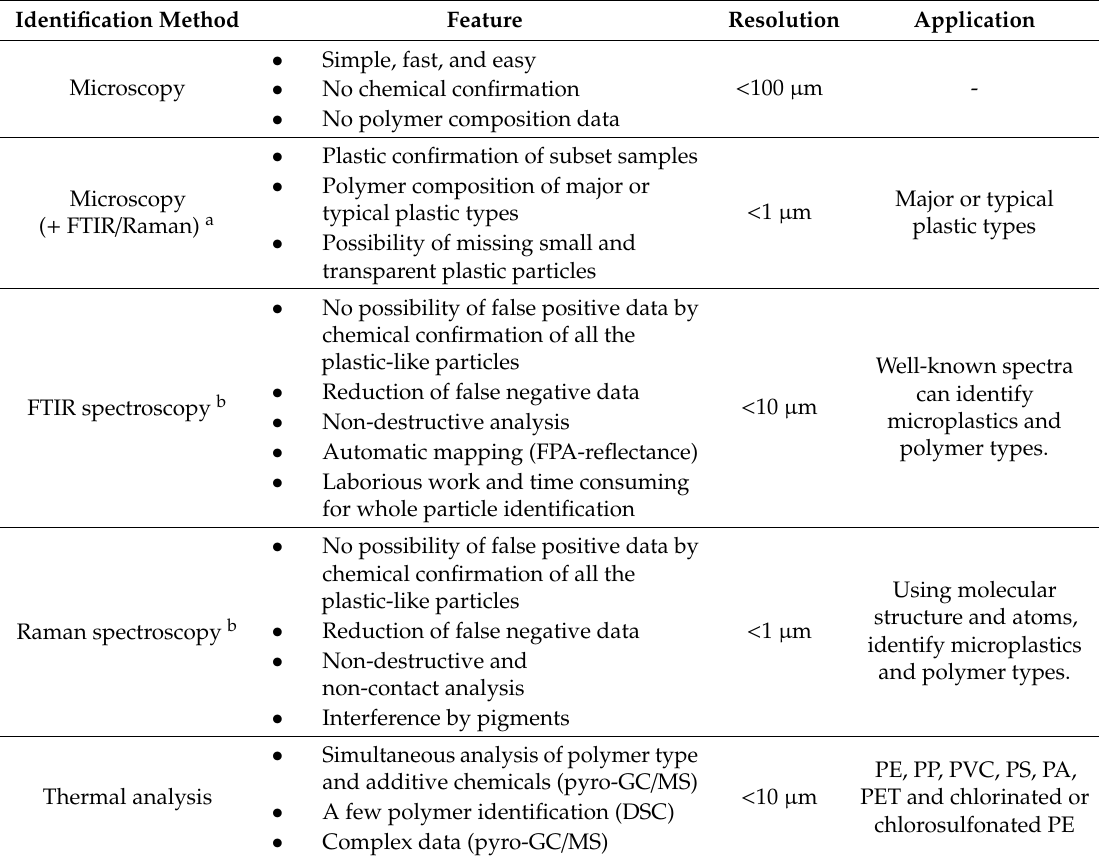
Table 2. Features, resolutions, and applications of currently studied MP identification